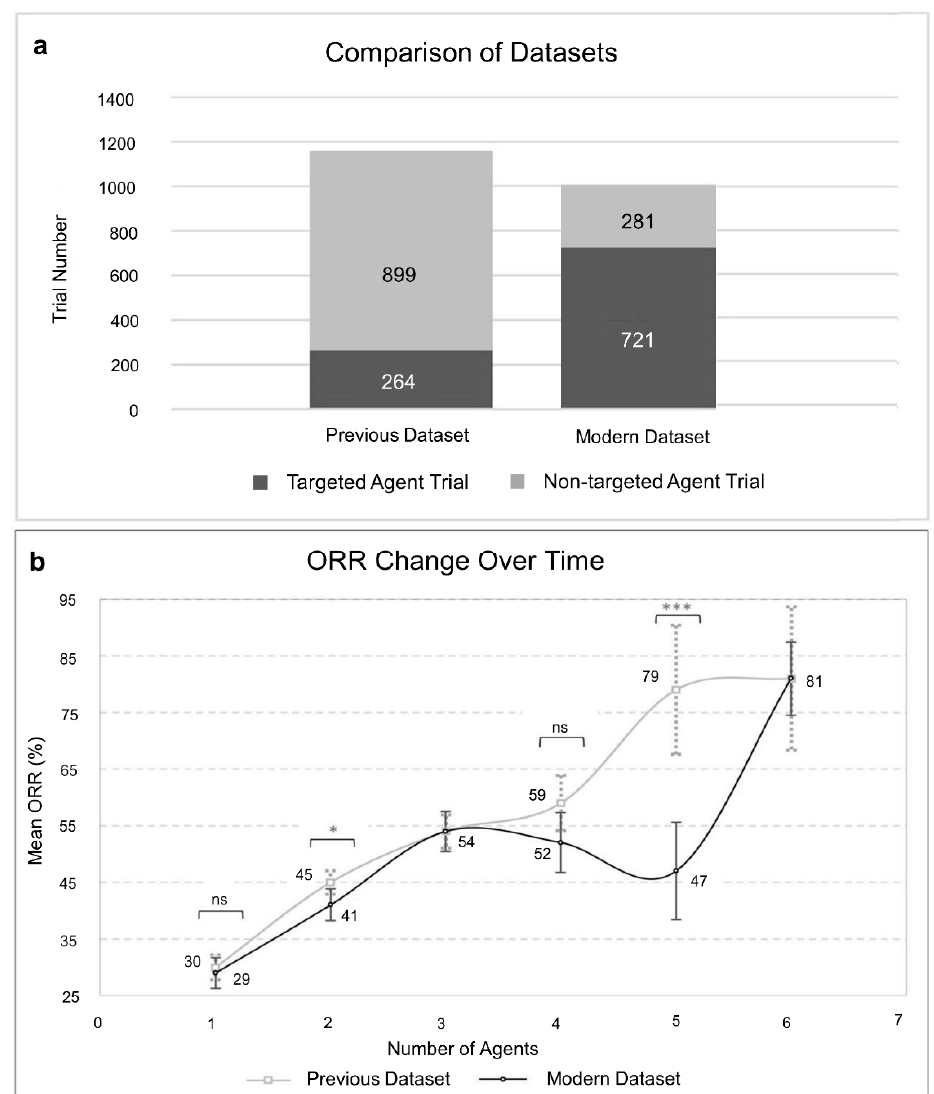
Figure 4. ORR trends over time. ( a ) , Proportion of targeted and non-targeted agent trials in the previous and modern ORR datasets. ( b ) , ORR as a function of the number of agents according to the combination tested in the previous and modern datasets. Previous dataset, n = 1163 and modern dataset, n = 1002. Points and error bars represent the mean ORR and 95% confidence interval, respectively. The statistical significance was estimated by two-tailed Student’s t -test, * p < 0.05, *** p < 0.001. Previous dataset from Kang et al. [38].